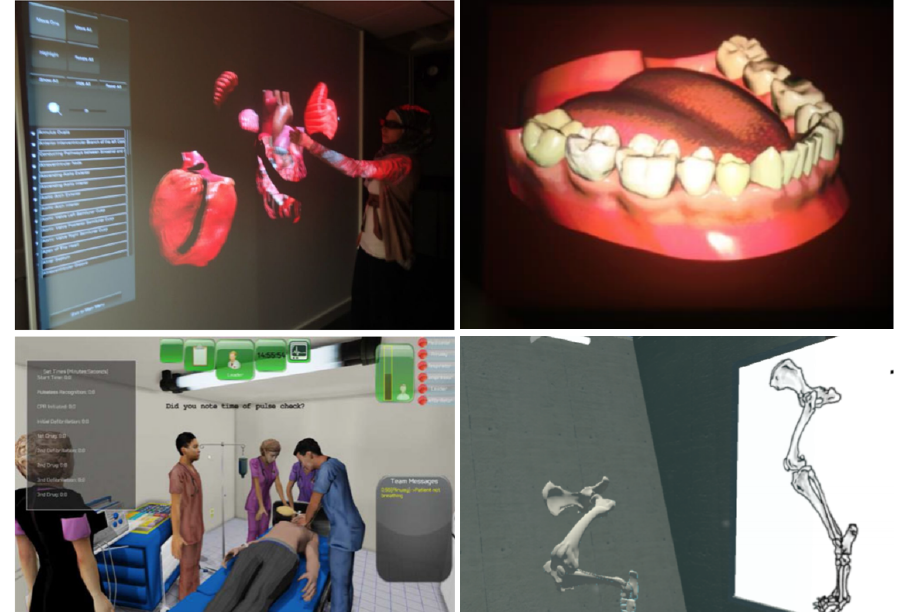
Figure 4. Screenshots of VR applications for medical education: A virtual reality heart anatomy system [39], Dental crown preparation training [60], Cardiac Life Support Training [89] and Anatomy Builder VR